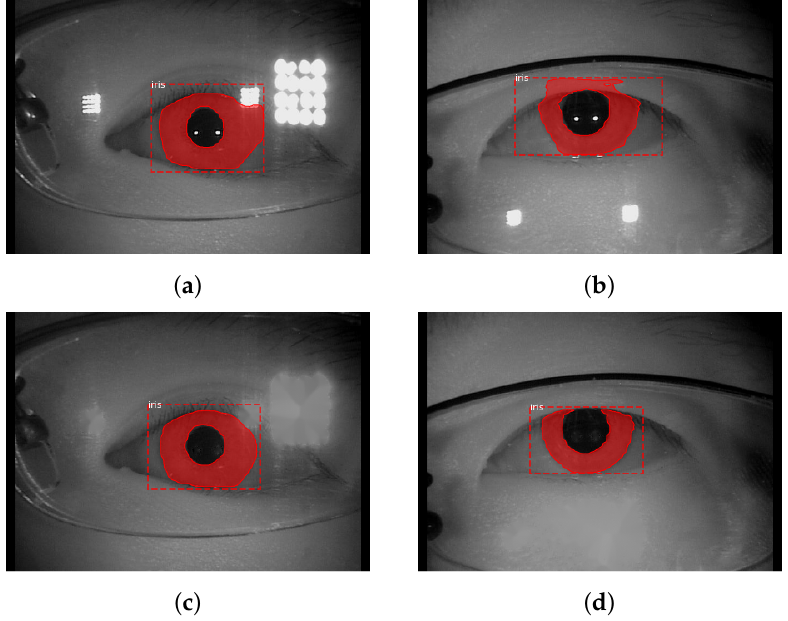
Figure 2. Sample results for the iris bounding box detection and mask segmentation from the method that was proposed in [41] ( a , c ) and with the proposed method to remove reflections ( b , d ). Large Margin Cosine Loss [12] followed [11] initially set the bias value to